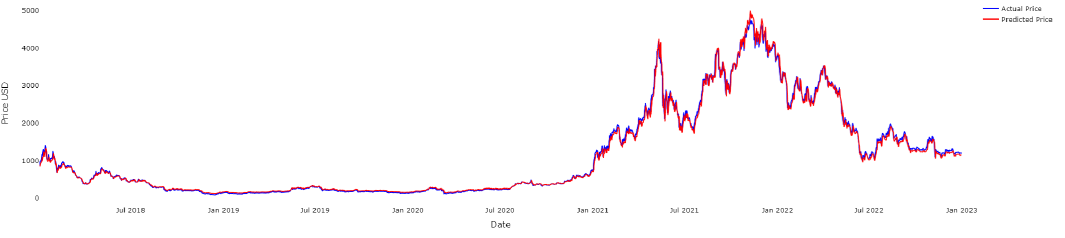
Figure 15. ETH—actual and predicted results using the GRU model.